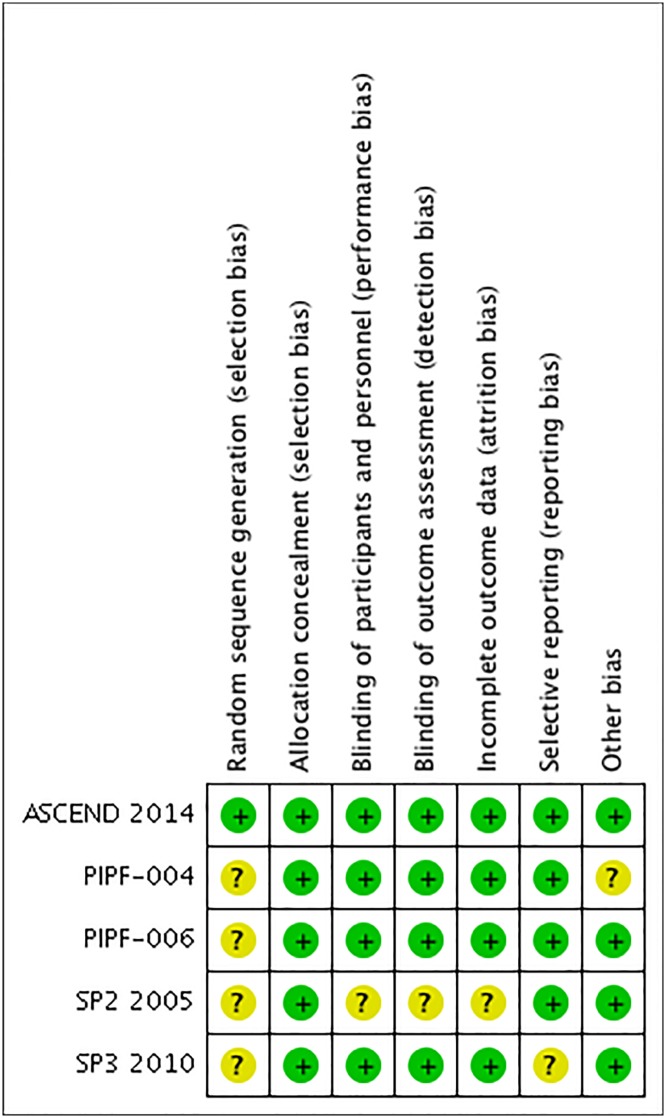
Risk of bias summary: review authors' judgment’s about each risk of bias item for each included study.